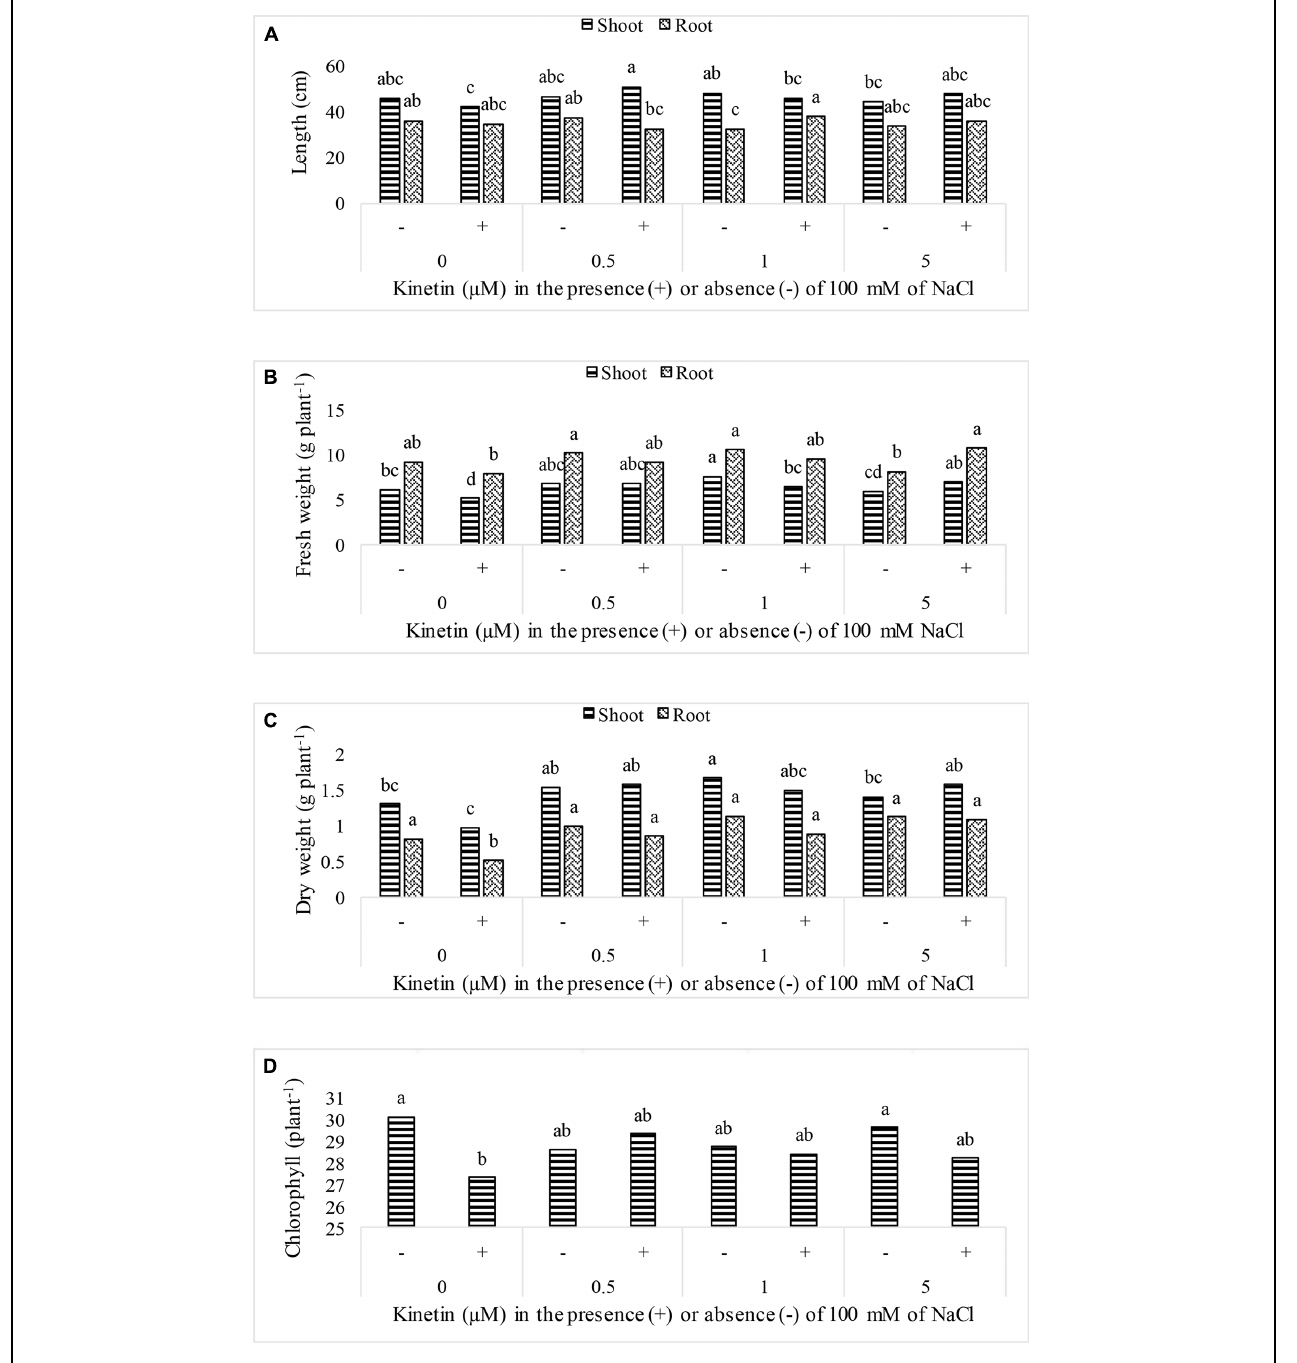
FIGURE 1 | Effect of different doses of Kn in the presence of absence of 100 mM NaCl on; (A) plant length, (B) fresh weight, (C) dry weight, and (D) chlorophyll contents of soybean cv. Daewonkong. Bars labeled with common letter(s) are not significantly different at the 5% level by DMRT.